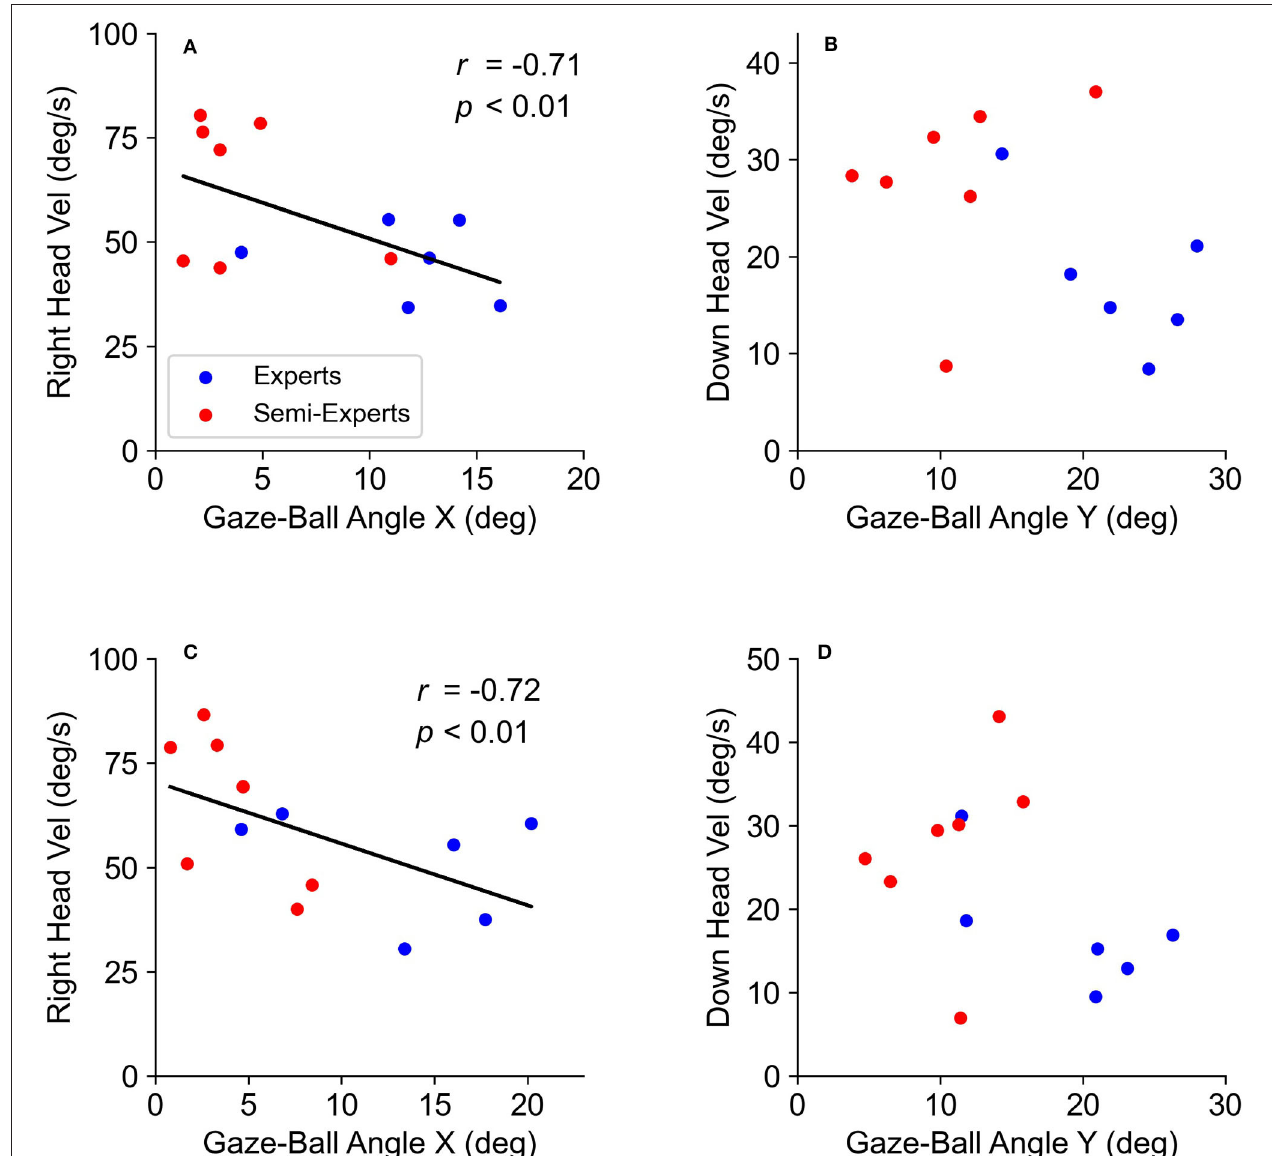
FIGURE 8 | The relationship between the gaze-ball angle and head velocity in each tempo condition. The top two panels (A,B) show the data at 130 bpm. The bottom two panels (C,D) show the data at 150